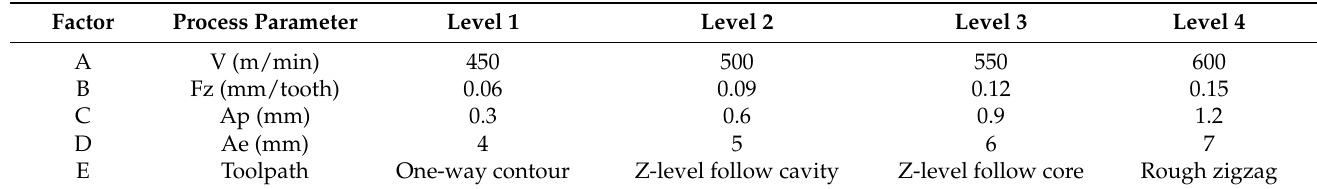
Table 3. Configuration of the Taguchi cutting parameters.